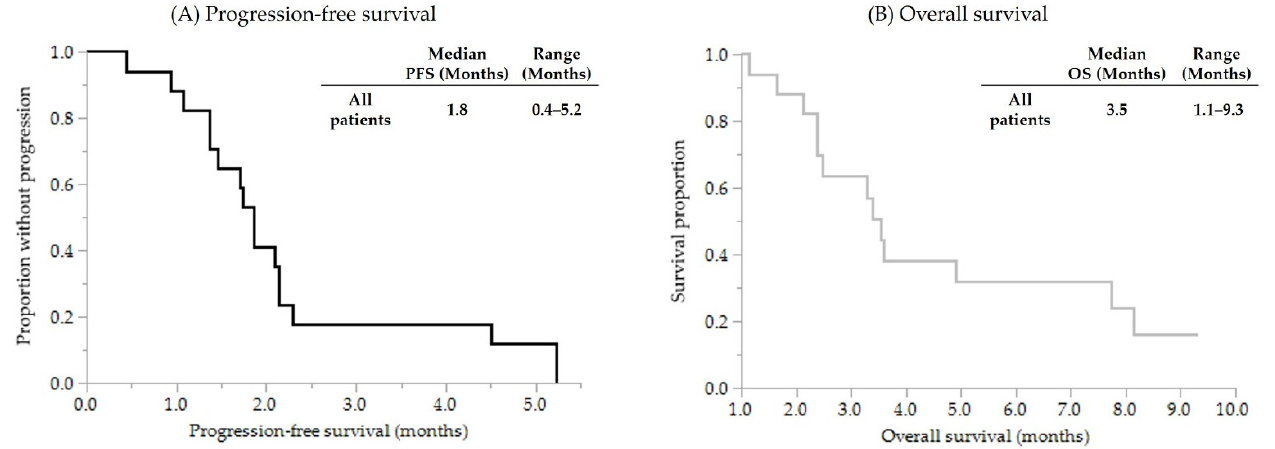
Figure 1. Kaplan–Meier survival curves for ( A ) progression-free survival and ( B ) overall